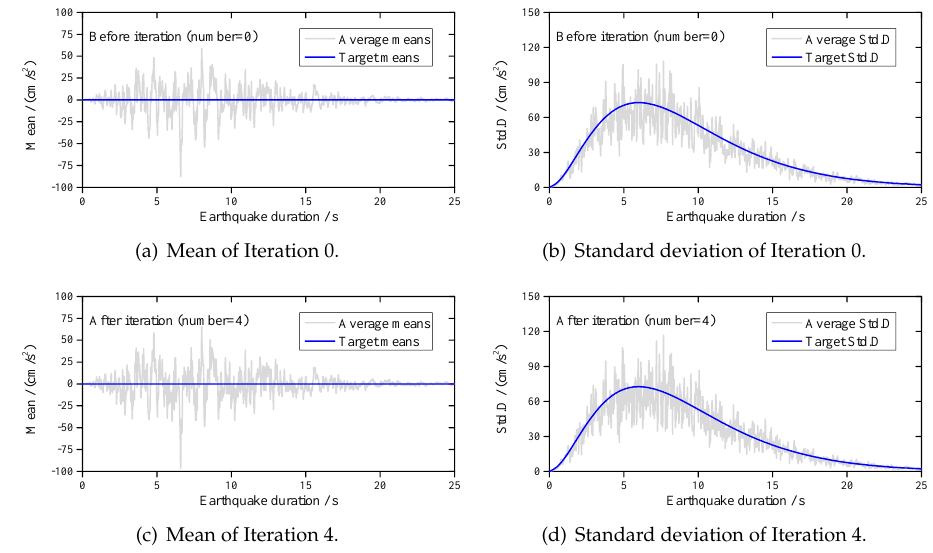
Figure 6. The means and standard deviations of the iterative PSD-based stochastic earthquake